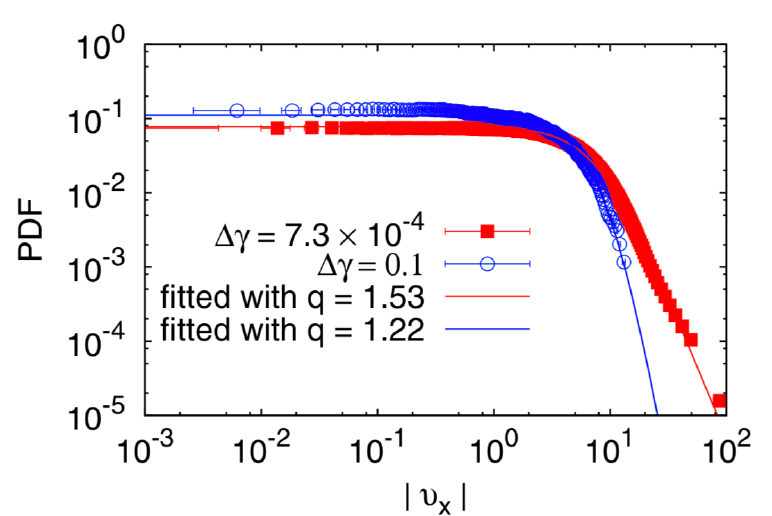
Figure 16. Probability density functions of the horizontal components of the randomly fluctuating dis- placements tracked during two typical increments of shear strain ( ∆ γ = 7.3 × 10 − 4 and ∆ γ = 10 − 1 ). The scatters correspond to experimental data, and the solid lines correspond to q -Gaussian fittings. From [110].